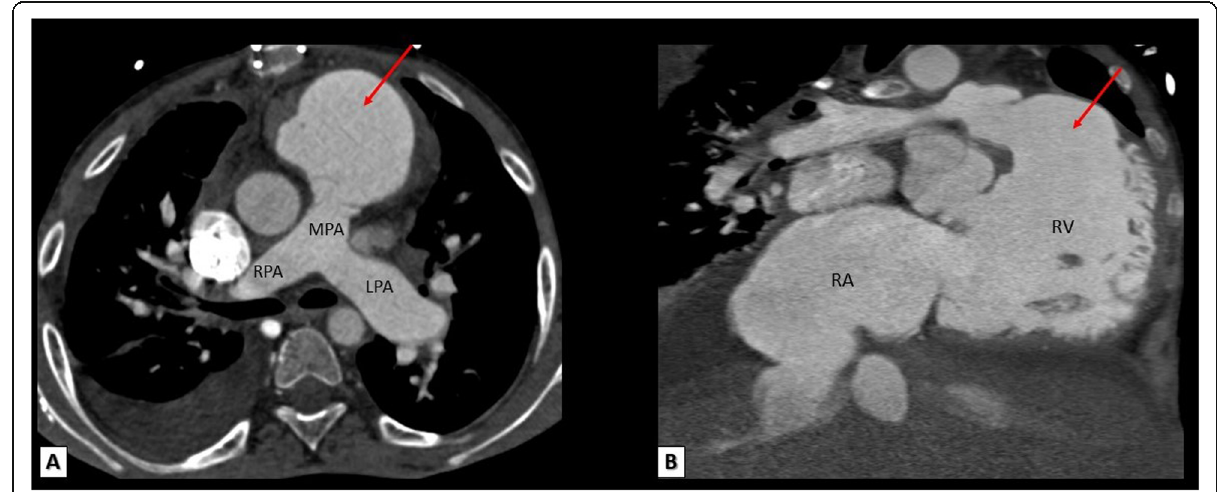
Fig. 13 A surgically repaired TOF patient. a Reformatted axial and b reformatted coronal MDCT images showing a large RVOT aneurysm (red arrows). MPA, main pulmonary artery; RPA, right pulmonary artery; LPA, left pulmonary artery; RV, right ventricle; RA, right